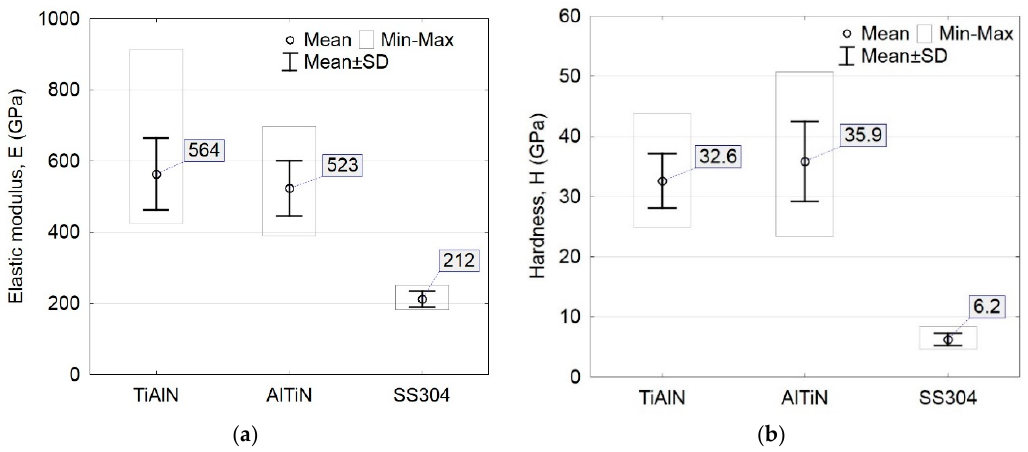
Figure 5. Elastic modulus and hardness of coated and bare SS304 samples. ( a ) elastic modulus; ( b ) hardness.